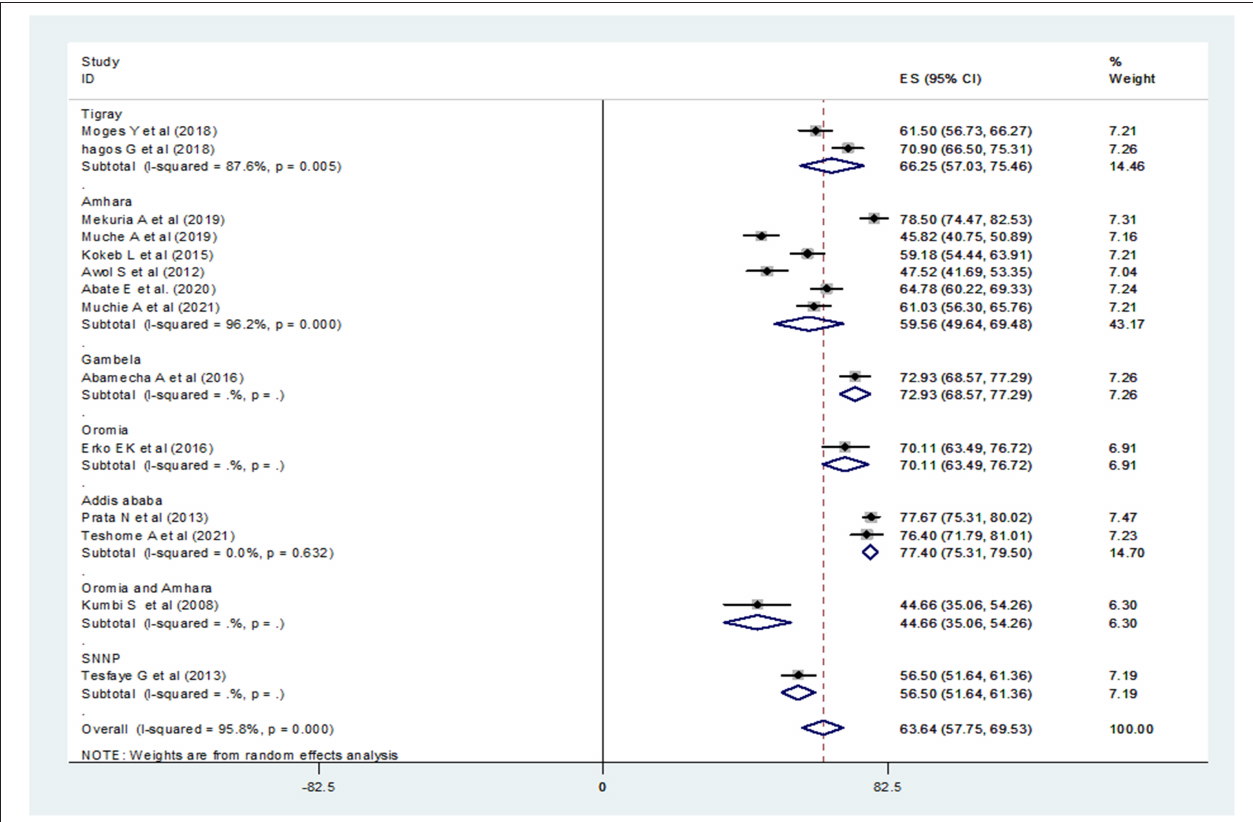
FIGURE 5 | Forest plot of the prevalence of PAFP with corresponding 95% CIs of the subgroup analysis based on the year of publication in